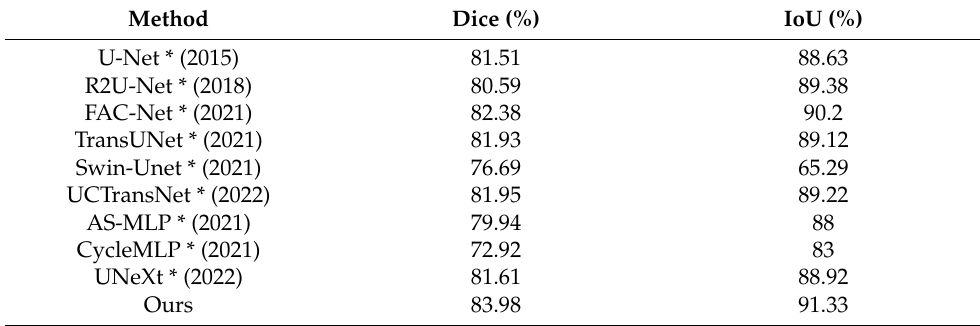
Table 7. ISBI2016 each comparison network evaluation